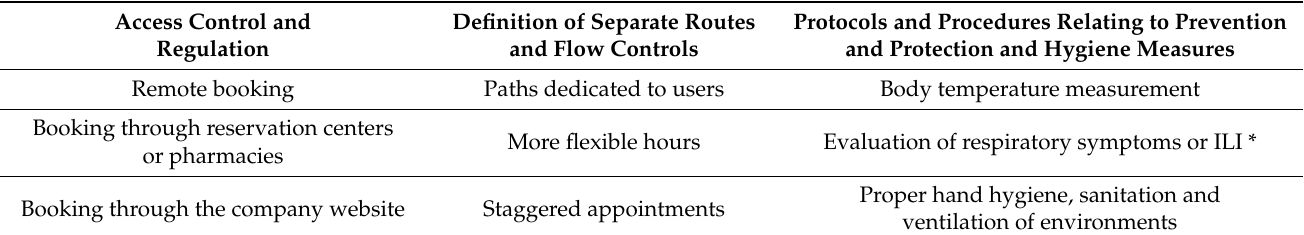
Table 1. Organizational strategies for the safety of immunization services. Modified from